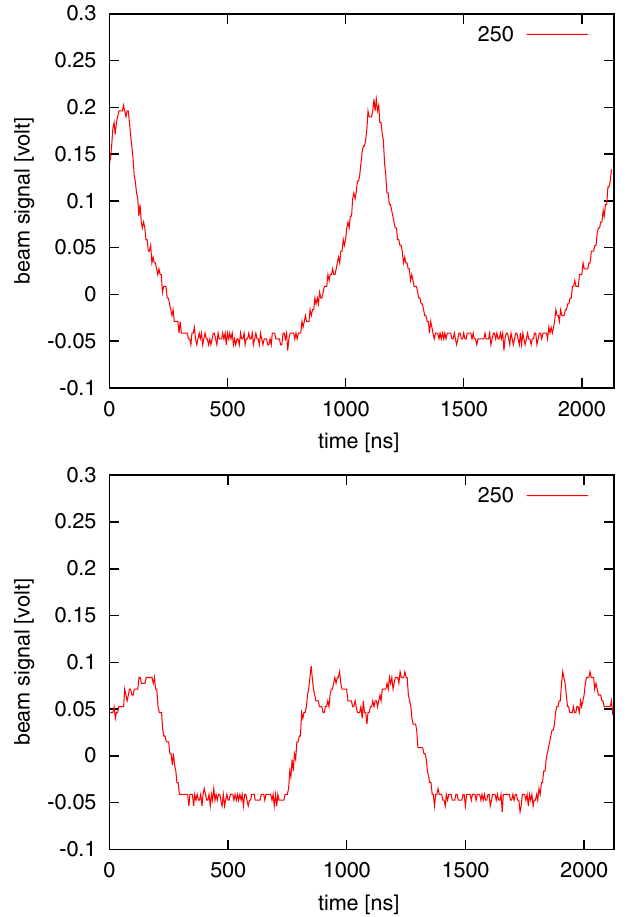
FIG. 12. (Color) Bunch shapes at 250th turn: (upper) fundamen- tal rf only; (lower) with 80% second harmonic, momentum offset of (cid:1) 0 : 2% , and phase sweep of 80 degrees. The negative offset of the signal is due to the AC-coupling circuit.